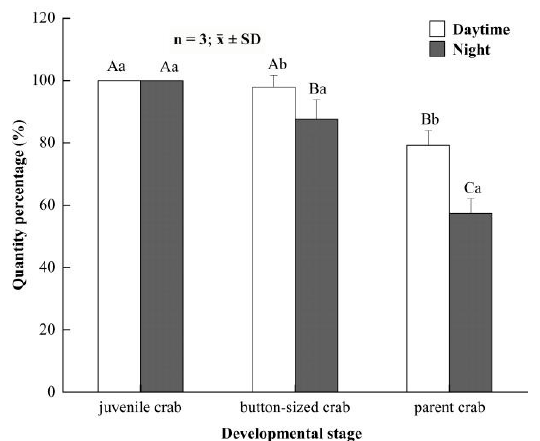
Figure 3. The hiding rate of Eriocheir sinensis in different developmental stages between daytime and night. Bars with same letters on the top indicate they have insignificant differences ( p > 0.05), and bars with different letters on the top indicate they have significant differences ( p < 0.05). Capital letters indicate the significance of hiding rates in different developmental stages, and lowercase letters indicate the significance of hiding and not hiding in the same stage.